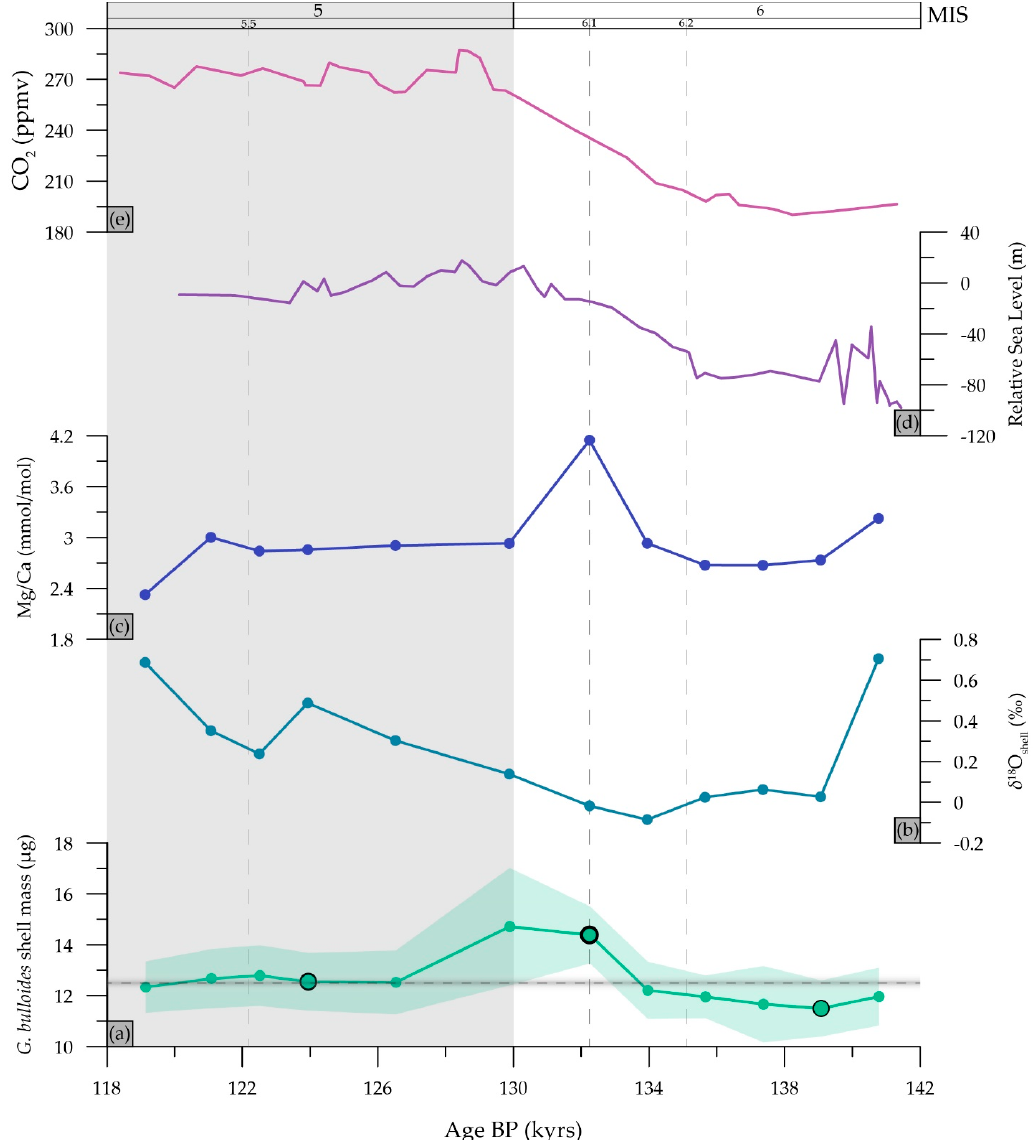
Figure 4. Climatic and geochemical records of the period surrounding the increased G. bulloides shell mass events during T-II: ( a ) average G. bulloides shell mass from GeoB 8502-2. The grey line denotes the mean shell mass of this period and the shading is the 1 σ confidence interval. Enlarged circles denote the samples that have been X-ray microscopically analysed. The thickness of their envelope line is proportional to the average shell wall thickness shown in Table 1; ( b ) δ 18 O shell of the foraminiferal calcite; ( c ) Mg/Ca ratios of the foraminiferal calcite; ( d ) the relative sea level record [46] is shown for comparison and ( e ) the record of atmospheric CO 2 from Vostok [44] is also shown for comparison. The 1 σ confidence interval for the shell mass plot is shown as transparent polygons. Numbers refer to Marine Isotopic Stages and substages. Geochemical and shell mass data are available in the Supplementary Tables.